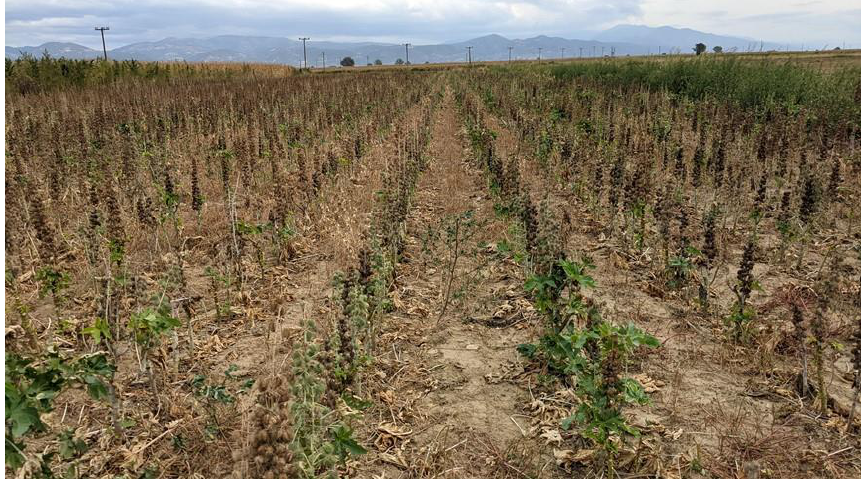
Figure 1. Experimental field just before harvesting